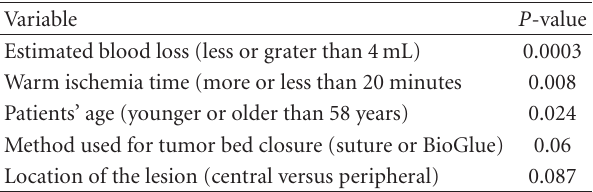
Table 1: Variables a ff ecting the postoperative renal function of the operated kidney after NSS.